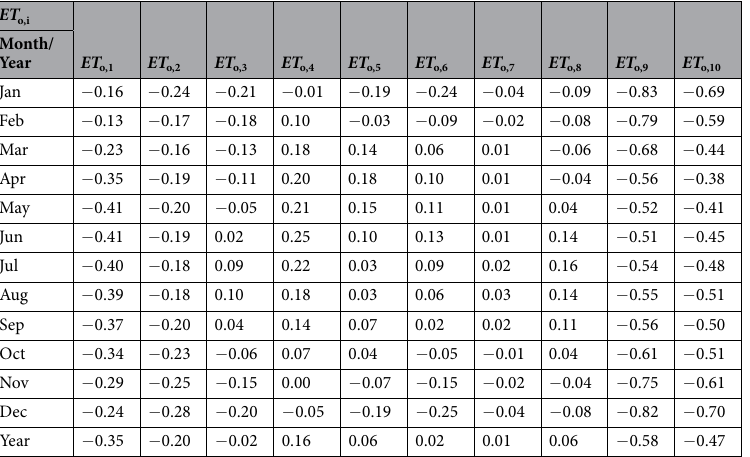
Table 3. Relative error ( RE ) values of the 10 selected methods for estimating ET o,i at the monthly and annual timescales for China.